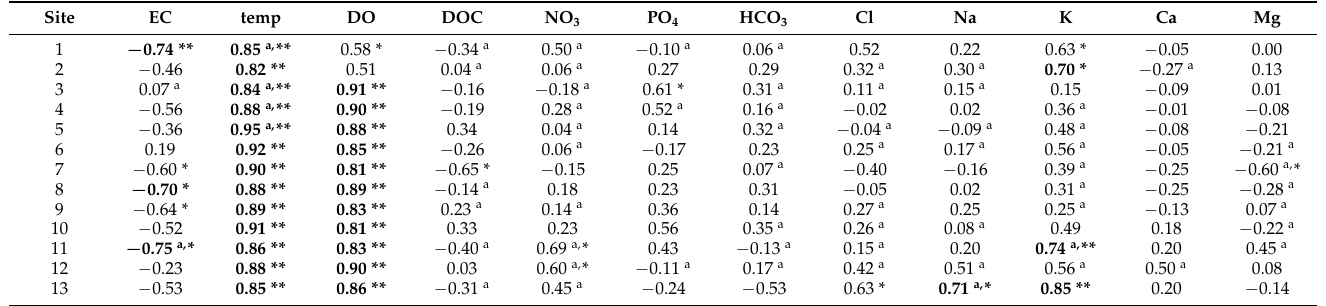
Table 2. Inter-annual Pearson and Spearman correlation coefficients at individual sampling